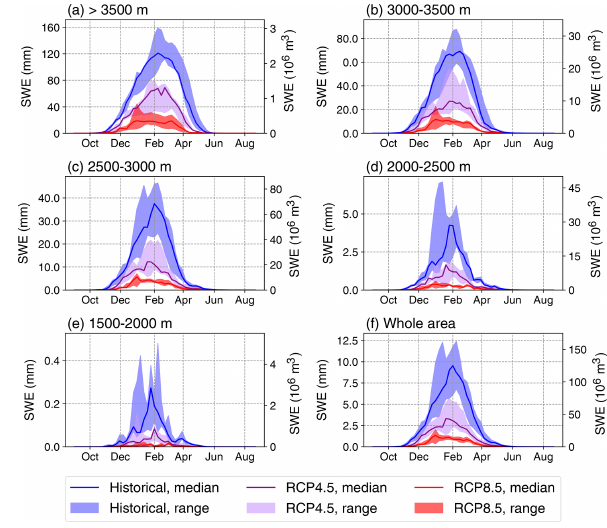
Figure 7. (a, b) Snow fraction of annual precipitation in the (a) his- torical and (b) RCP8.5 scenario (average between all three GCM- driven simulations). (c) Difference between (b) and (a) . (d) Snow fraction of annual precipitation as a function of elevation, in each scenario (historical, RCP4.5 and RCP8.5; three-model average) and in the assimilated control simulation of T20a.